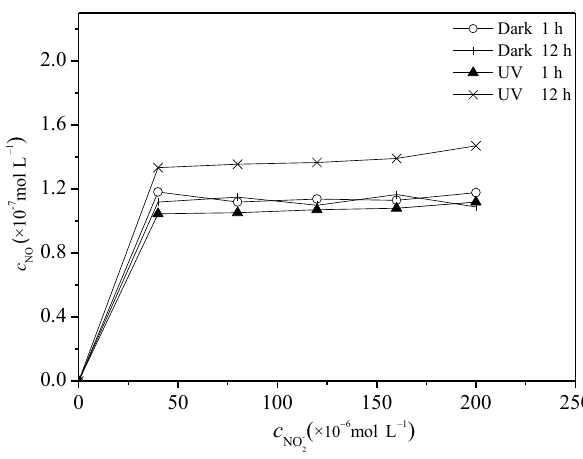
Figure 3. Relationship between nitric oxide concentrations and flu- orescence intensities.